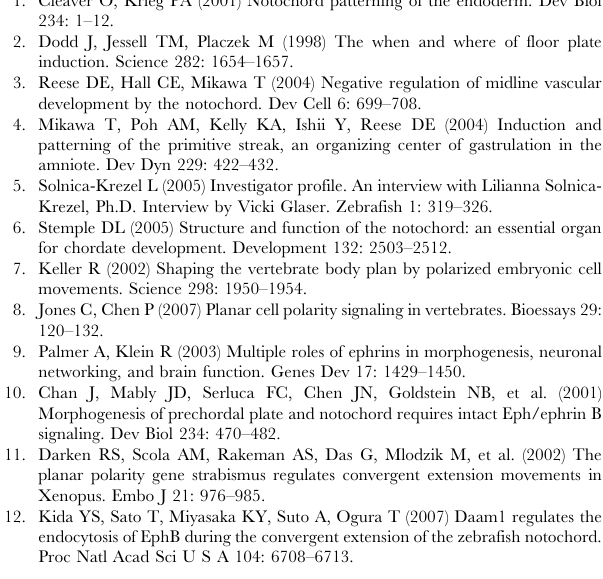
Figure S5 Localization pattern of collagen IV over the notochord surface. An embryo at late middle-late tailbud stages stained for the anti-mouse collagen IV (B) and with phalloidin (A). Images were taken under a confocal microscope. Lateral view, anterior is to the left. neurula stage embryo shown in Figure 3A stained with anti-aPKC antibody (red) and phalloidin (green). Signal of aPKC in the ventral side of the notochord is indicated by arrows. early-tailbud stage embryo shown in Figure 3D stained with anti- aPKC antibody (red) and phalloidin (green). Signal of aPKC in the ventral side of the notochord is indicated by